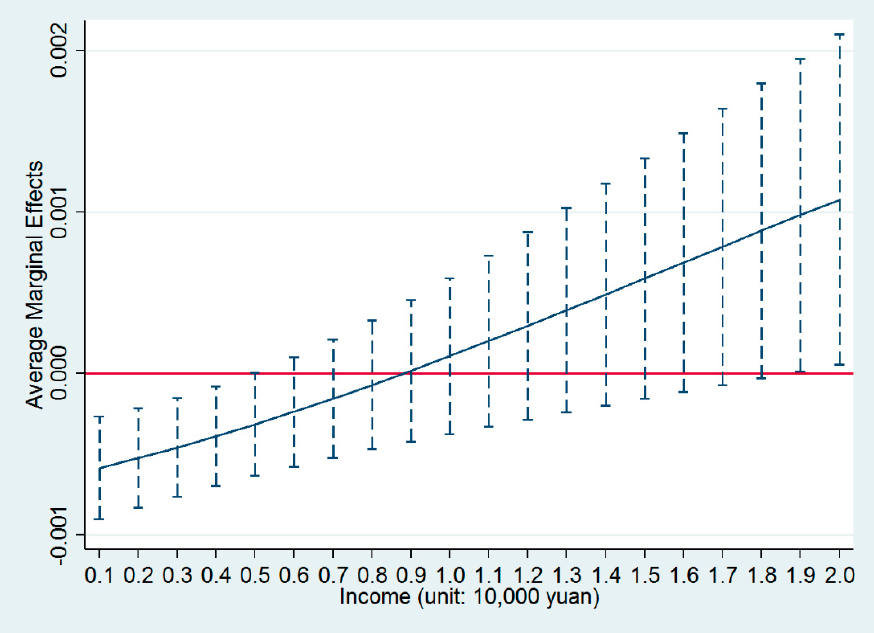
Figure 4. Average marginal effects of PM2.5 with 90% confidence intervals using the probit regression model.